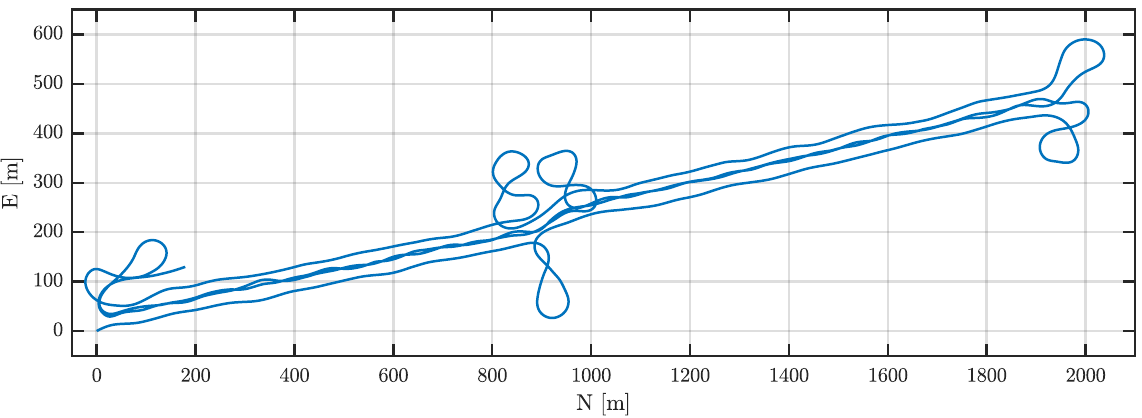
Figure 2. The UAV flight used to generate synthetic sensor observations. This corresponds to a real-world corridor mapping mission and includes specific eight-shaped maneuvers that introduce the necessary dynamics to enhance the observability of inertial biases. Estimating